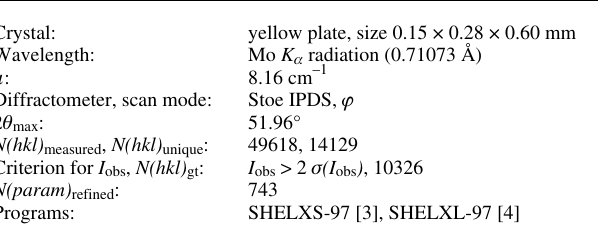
Table 1. Data collection and handling.